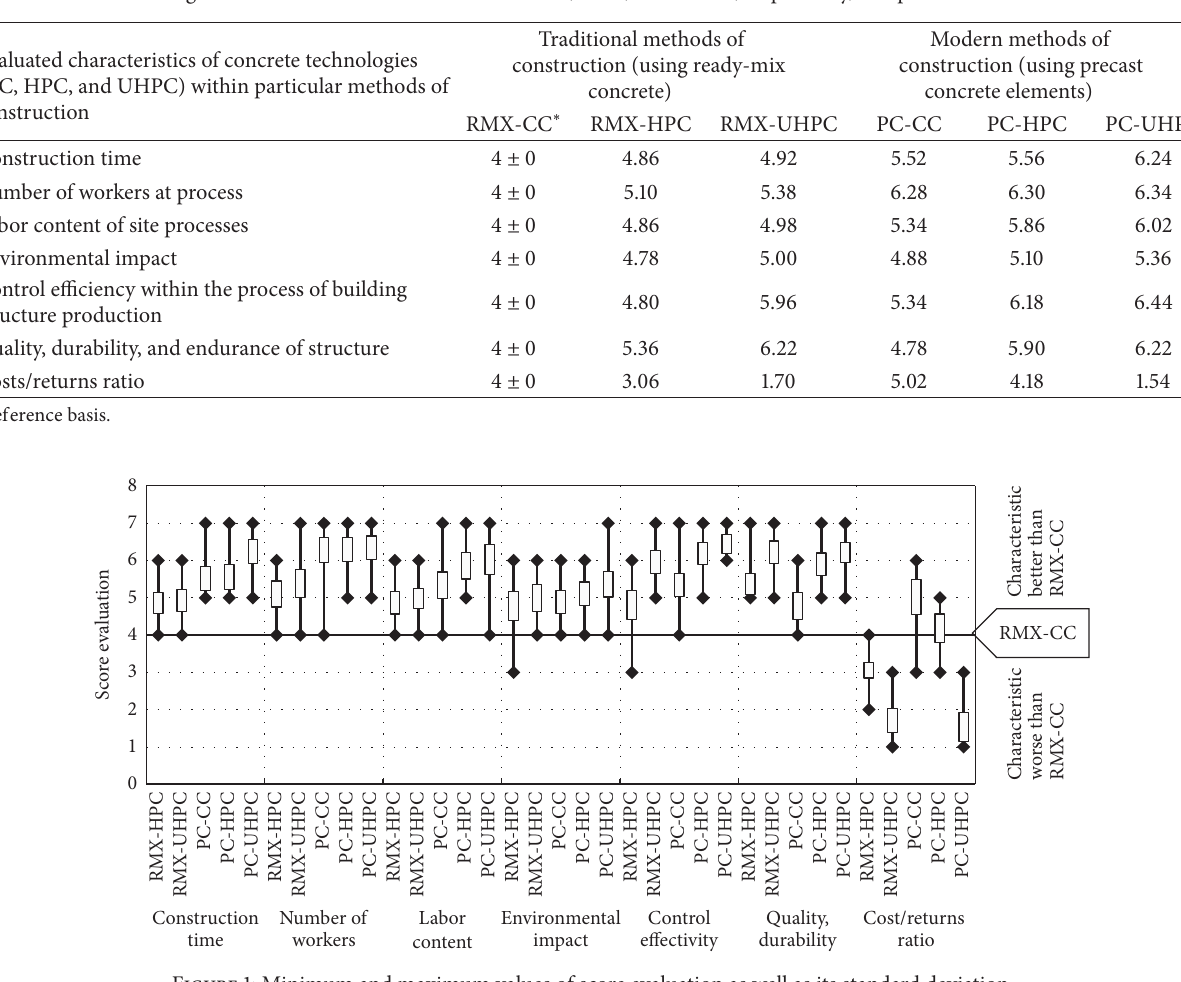
Figure 1: Minimum and maximum values of score evaluation as well as its standard